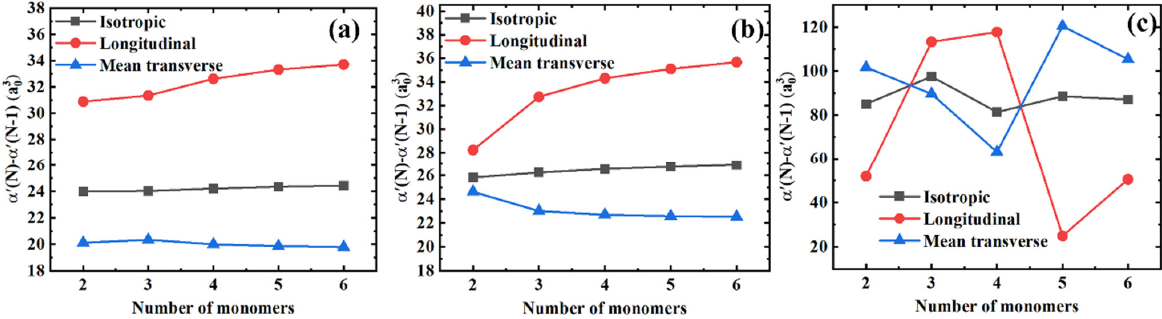
Figure 4. Differences in the isotropic, longitudinal, and mean transverse polarizability components between the consecutive polymer chains for different polymer materials. ( a ) PE; ( b ) PTFE; and ( c ) PS.